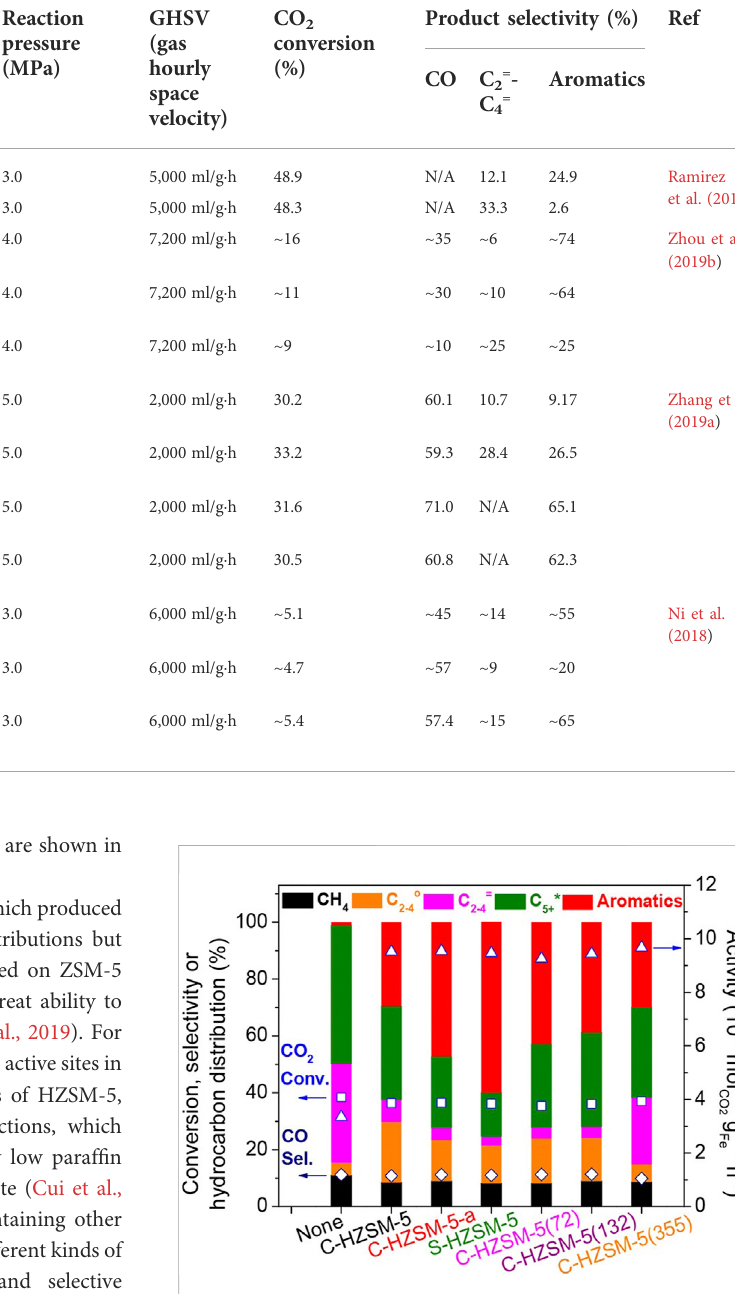
FIGURE 7 CO 2 conversion and product selectivity over sole ZnFeO x - 4.25Na or composite catalysts containing ZnFeO x -4.25Na and various zeolites (Cui et al.,